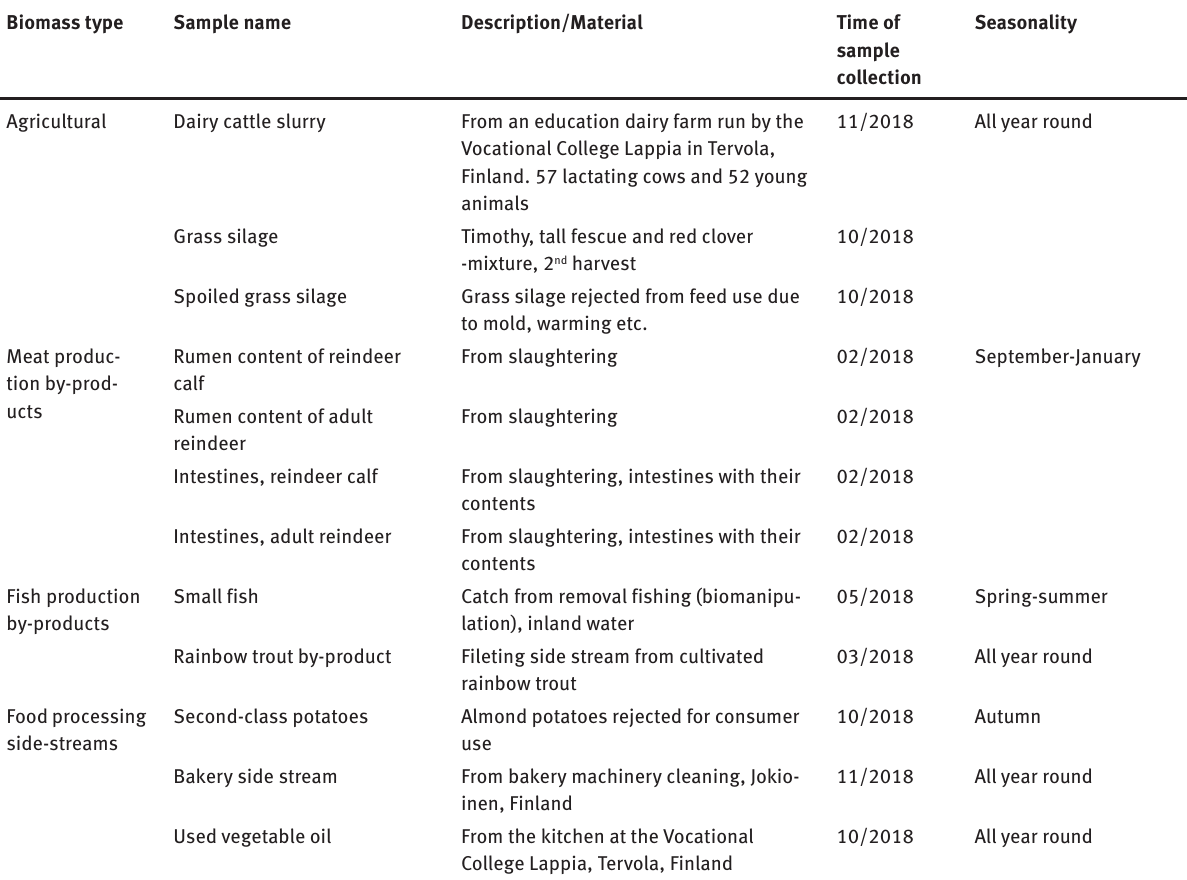
Table 1 : Description of the substrates analyzed in this study and the seasonality of each material in Lapland